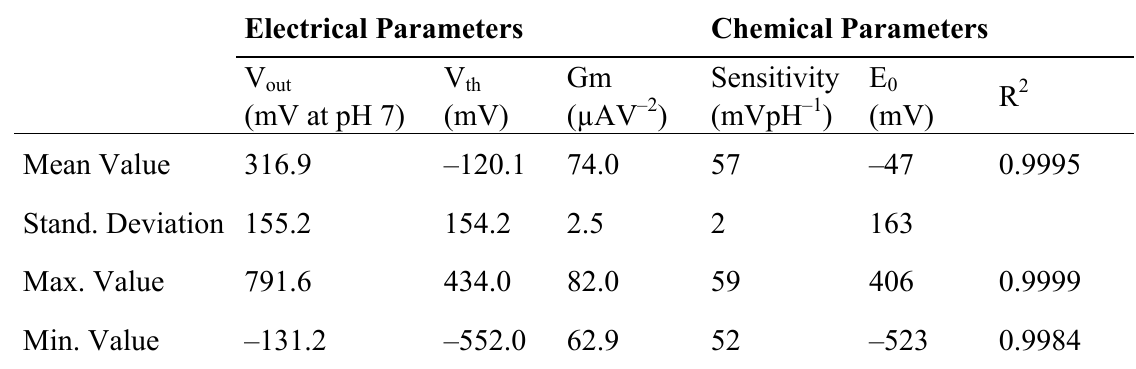
Table 1. Electrical and chemical characteristics measured for a complete wafer (n =